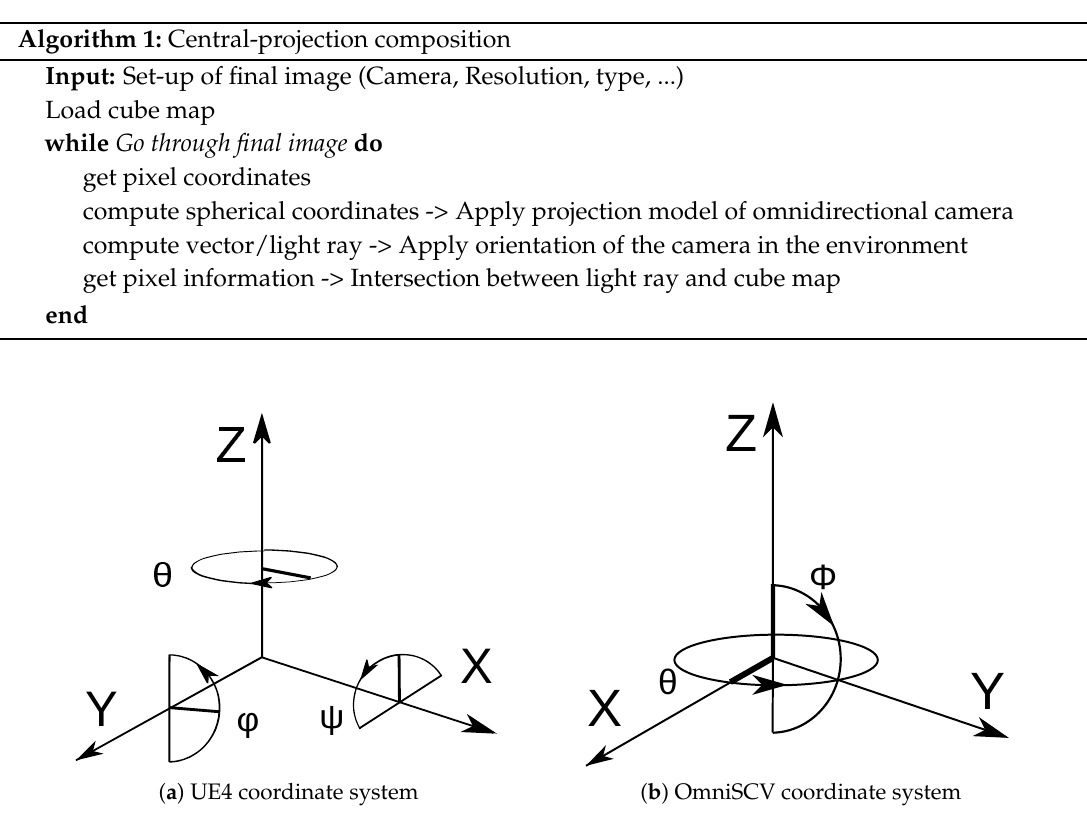
Figure 6. ( a ): Coordinate system used in graphic engines focused on first-person video games; ( b ): Coordinate system of our image